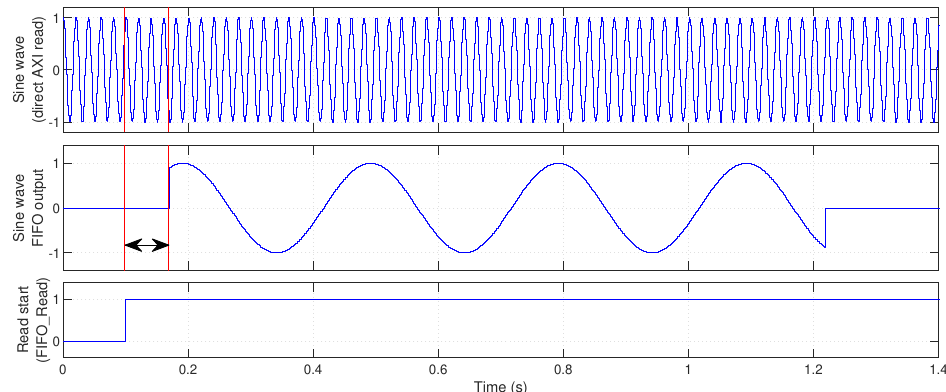
Figure 16. Sine wave full-sampled acquisition using a FIFO window of 1000 samples, when the processor sampling time is 1050 µ